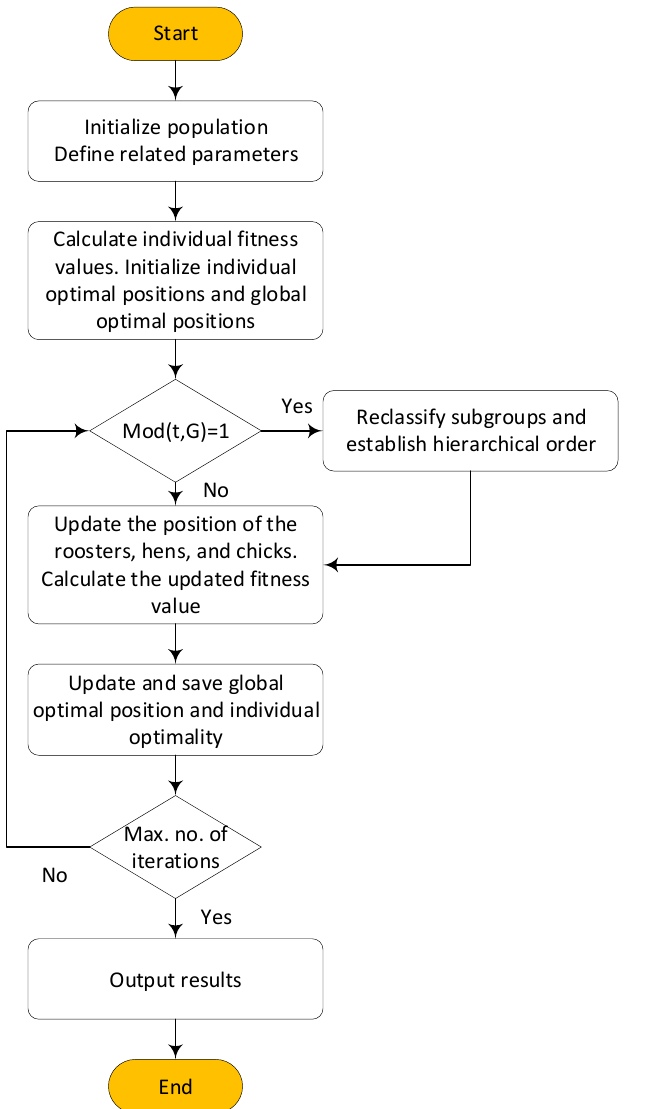
Figure 8. The chicken swarm optimisation